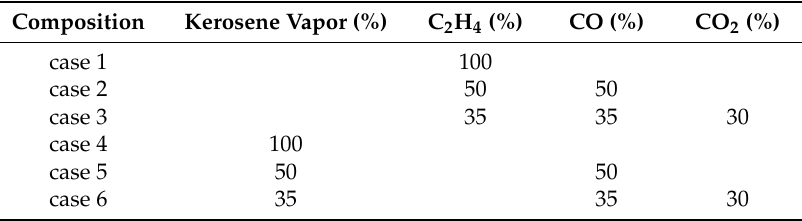
Table 1. Post combustion simulated gas